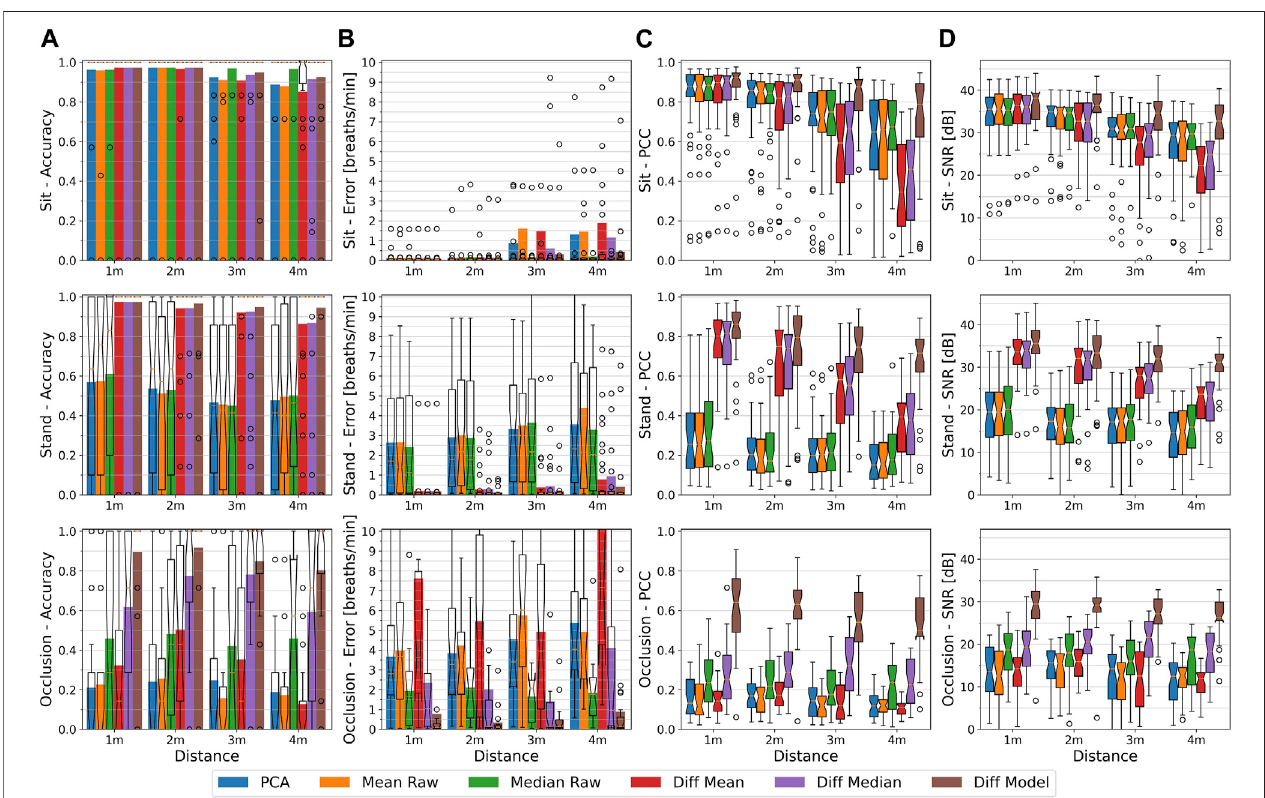
FIGURE7| From (A – D) :Therespiratoryrateaccuracy,errorsinbreathperminute,PearsonCorrelationCoef fi cientw.r.t.thegroundtruthsignal,andsignaltonoise ratio of the different methods at the chest. Plots are separated from top to bottom by the sitting, standing, and occlusion condition and by the distance between 1 and 4 m,withallrespiratoryrates(10and 15 bpm) combined.Accuracyand errormetrics useaFastFourierTransform window withalengthof48 s.Thecoloredbars show the averages, while overlay box plots show median (middle parts) and whiskers marking data within 1.5 IQR. The breathing rate is detected slightly less accurately and the PCC and SNR values decrease when the user is further away from the camera. The Diff Model method remains robust for different distances and conditions.